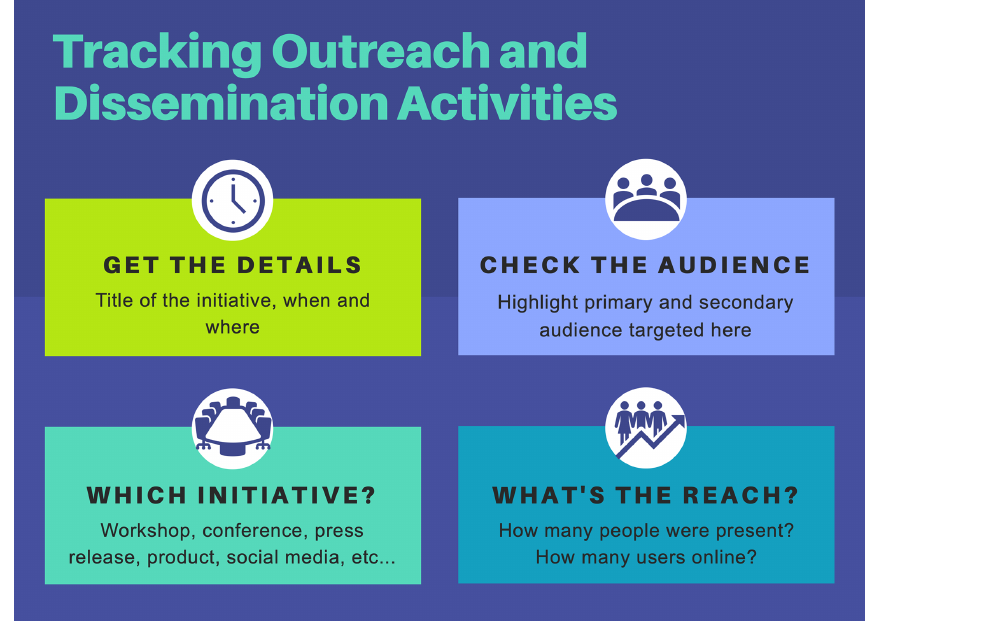
Figure 2. Schematic summary of the most relevant aspects to track and evaluate the performance of outreach and dissemination